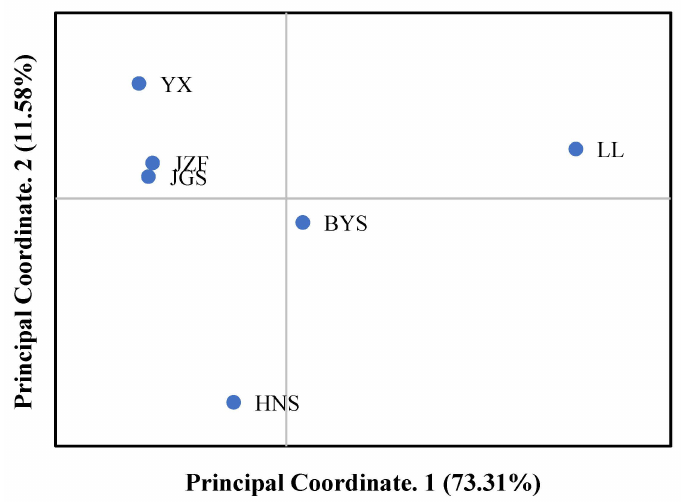
Figure 4. Principal coordinate analysis (PCoA) among six populations based on mean genotypic genetic